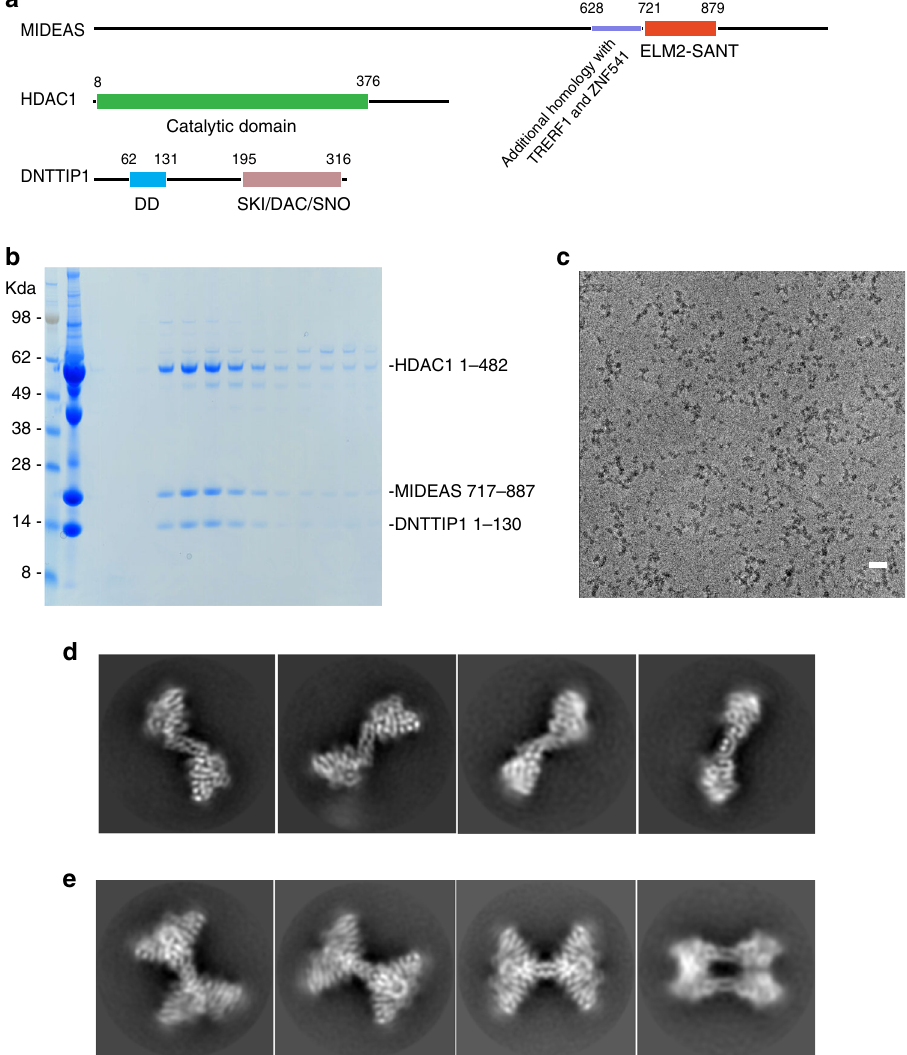
Fig. 4 Cryo-electron microscopy of the MiDAC complex. a Schematic of the domain structures of MIDEAS, HDAC1 and DNTTIP1: components of the MiDAC complex. b SDS-PAGE of the gel- fi ltration puri fi cation of the MiDAC complex on a Superdex-S200 column. c Section of an electron micrograph of the MiDAC complex. Scale bar: 20 nm. d 2D class averages of the dimer complex from Relion3. e 2D class averages of the tetramer complex from